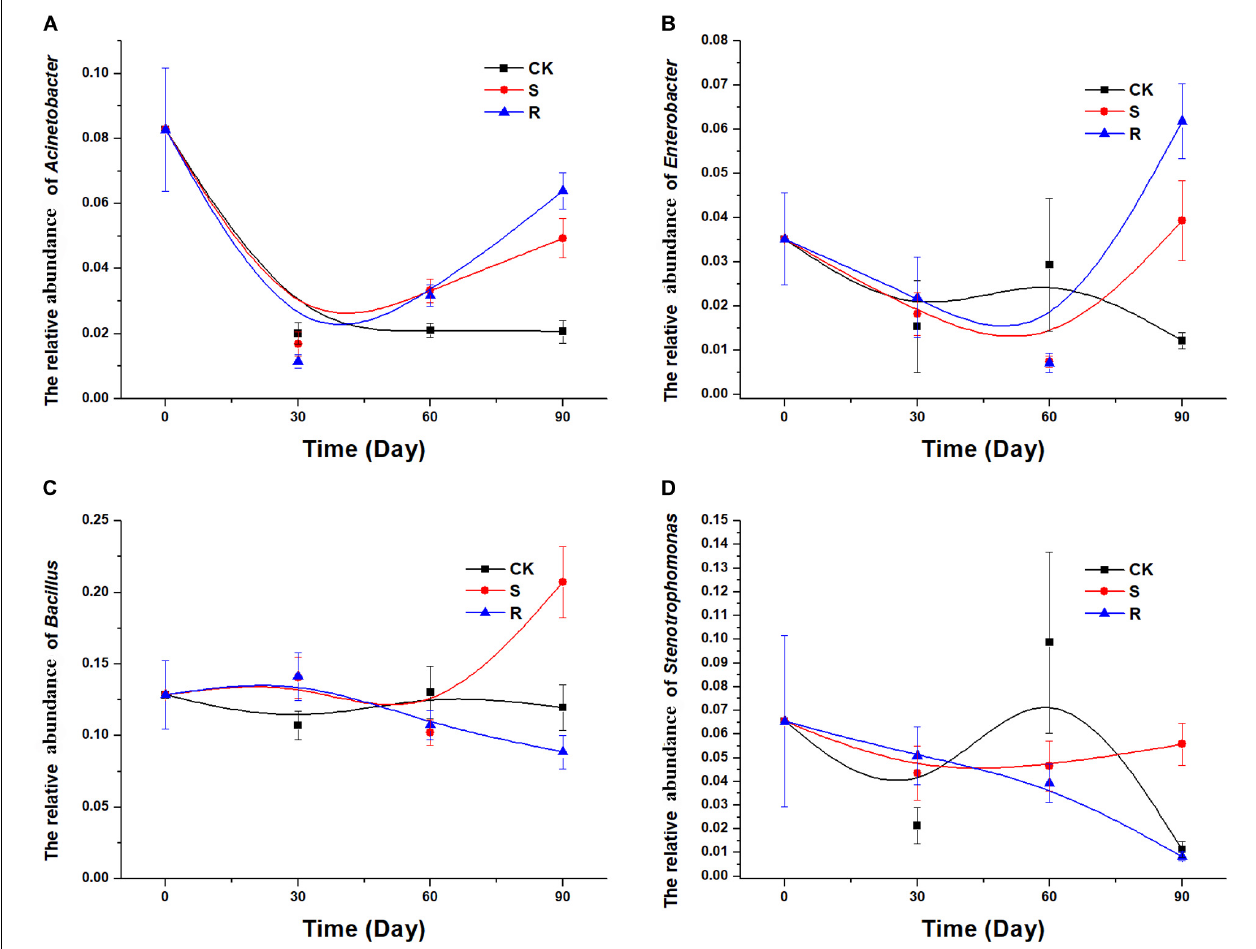
FIGURE 5 | Relative abundance of several genera over time: (A) Acinetobacter, (B) Enterobacter, (C) Bacillus ; (D) Stenotrophomonas . CK, control group ( N = 8); R, treatment with root functional microflora ( N = 24); S, treatment with soil functional microflora ( N =